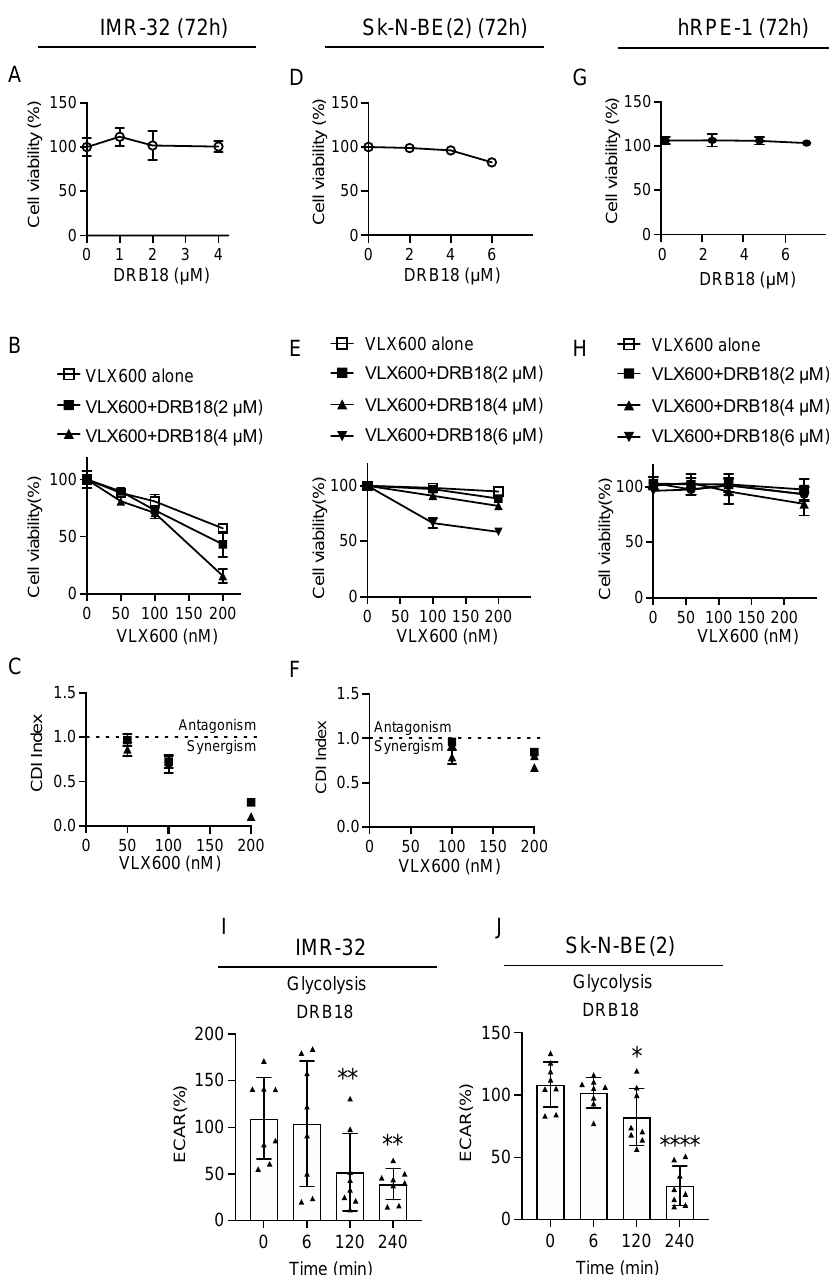
Figure 7. VLX600 synergized with GLUT inhibitor DRB18 in neuroblastoma cells. ( A , D ) Concentrations of DRB18 generating minimal cytotoxic effects on IMR-32 and Sk-N-BE(2) cells after 72 h treatment. ( B , C , E , F ) IMR-32 and Sk-N-BE(2) cells were treated with DMSO, VLX600 alone, or VLX600/DRB18 for 72 h. CDI was calculated as follows: CDI = AB/(A × B) where: AB = cell viability value for the combination of the VLX600 and DRB18. A and B = cell viability value for the single treatment VLX600 or DRB18. A CDI value <1, =1 or >1 indicates that the drugs are synergistic, additive or antagonistic, respectively. A CDI value less than 0.7 indicates that the drugs are significantly synergistic [24]. ( G ) Concentrations of DRB18 used in IMR-32 and Sk-N-BE(2) cells did not generate obvious cytotoxicity in hRPE-1 cells. ( H ) hRPE-1 cells treated with DMSO, VLX600 alone, or VLX600/DRB18 for 72 h. Concentrations were consistent with that used in IMR-32 and Sk-N-BE(2) cells and no obvious cytotoxicity was observed in hRPE-1 cells. ( I , J ) Glycolysis in IMR-32 and Sk-N-BE(2) cells treated with 4 µM DRB18. Extracellular acidification rate (ECAR) was measured at indicated time points after DRB18 injection (6, 120 and 240 min). Data are shown as mean ± SD, statistical analysis using two-tailed paired t -test. * p < 0.05, ** p < 0.01 and **** p < 0.0001.